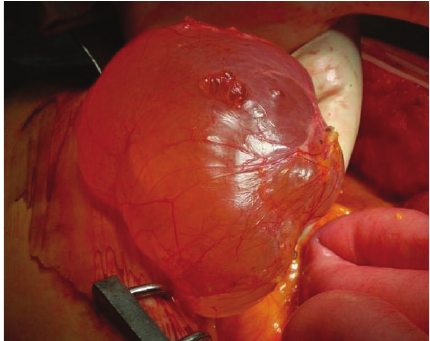
Figure 1: Abdominal ultrasonography showing a solid, hetero- geneous retroperitoneal mass with multiple foci of variable size, occupying most of abdominal and pelvic cavity.